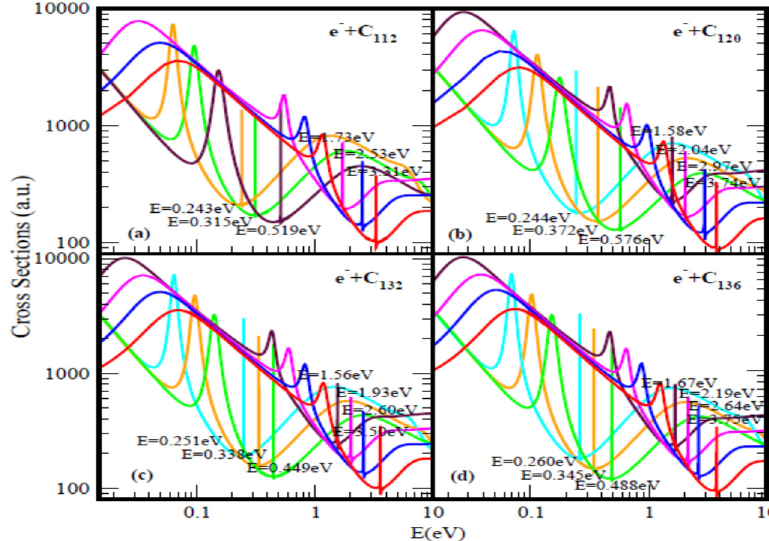
Figure 2. Total cross sections (a.u.) for ( a ) C 112 , ( b ) C 120 , ( c ) C 132 and ( d ) C 136 . The red, blue, pink and brown (no brown curve for C 112 ) curves represent TCSs for the ground and induced metastable states (first, second and third), respectively. For C 112 (orange, green and brown), while for C 120 , C 132 and C 136 (light blue, orange and green) curves correspond to the excited TCSs. The dramatically sharp resonances correspond to the anions formed during the collisions. Table 1. Fullerene ground (GR-S), metastable (MS-n, n = 1, 2, 3) and first excited (EXT-1), second excited (EXT-2) and third excited (EXT-3) anionic states binding energies (BEs). R-T refers to the energy position of the ground state R-T minimum. The measured EAs are represented as Expt. All the energies are in eV. Full. Bes GR-S